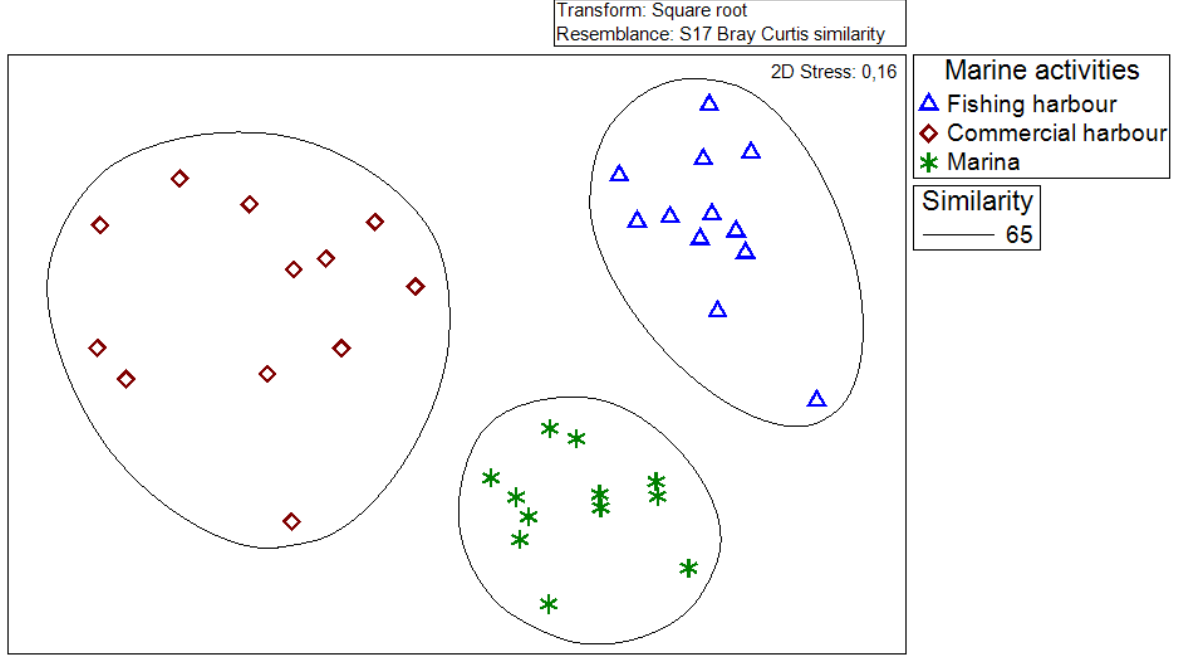
Figure 5. Spatial ordination of samples (3 × 4 replicates for each harbour) provided by n-MDS: the three site groups corresponding to the three main marine activities of each harbour are represented by continuous-line ovals representing the percentage of similarity measured by cluster analysis.